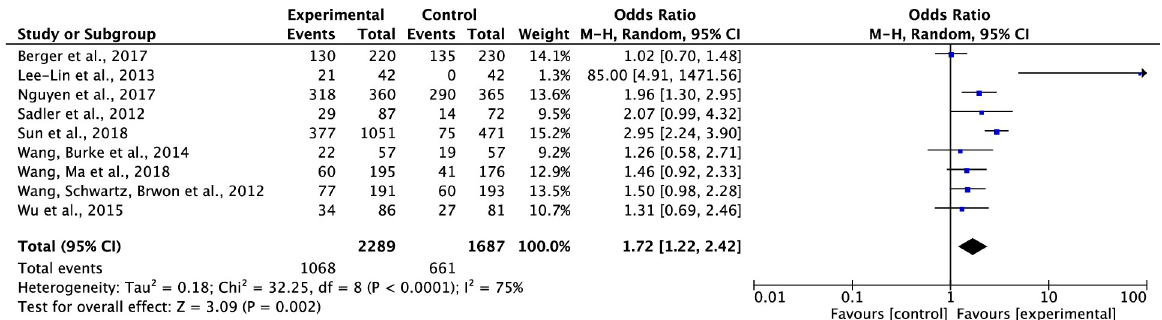
Fig 4. Forest plot of participants’ completion of cancer screening.